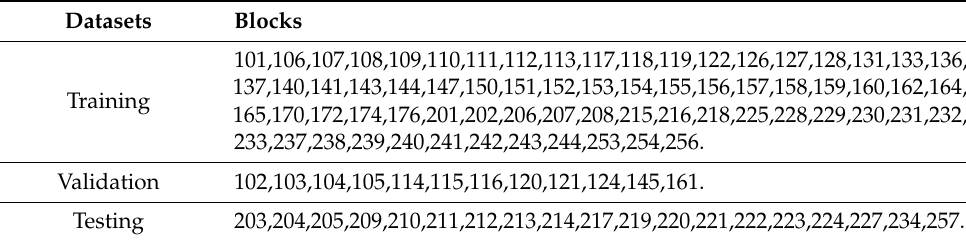
Table 2. The distribution of datasets based on blocks area.